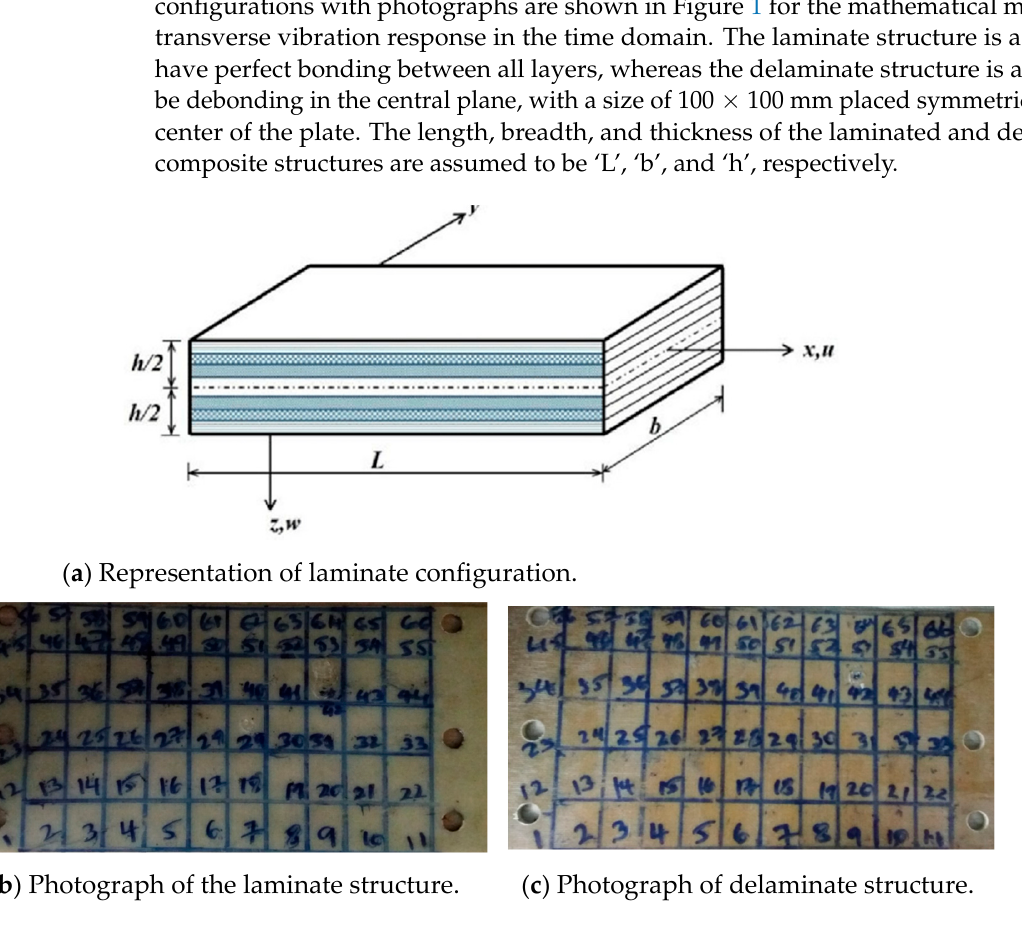
Figure 1. Composite plate configuration.